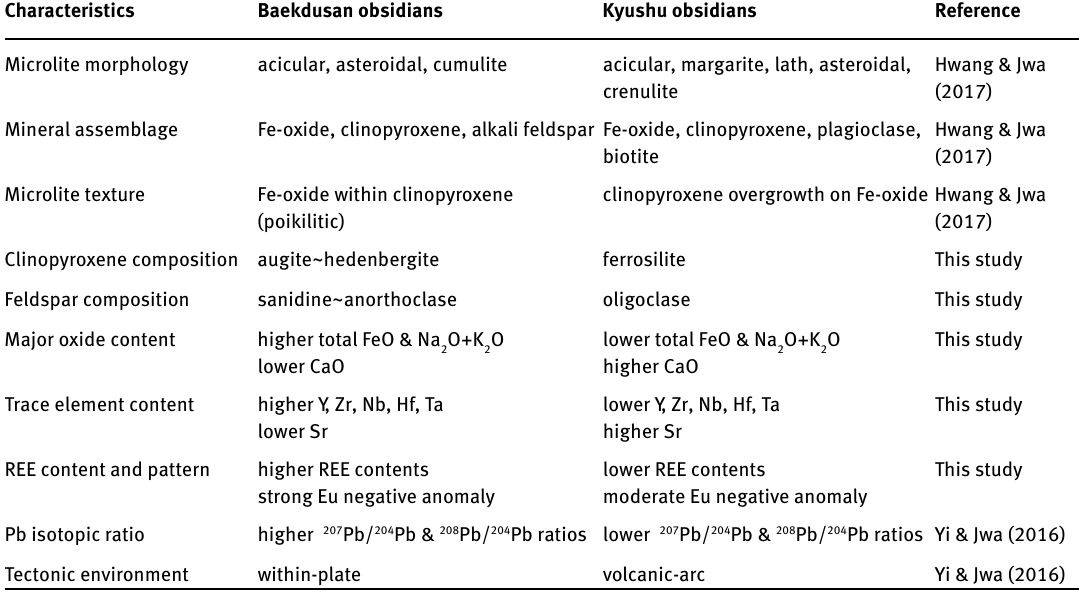
Table 6. Mineralogical and geochemical characteristics of the Baekdusan and Kyushu obsidians.